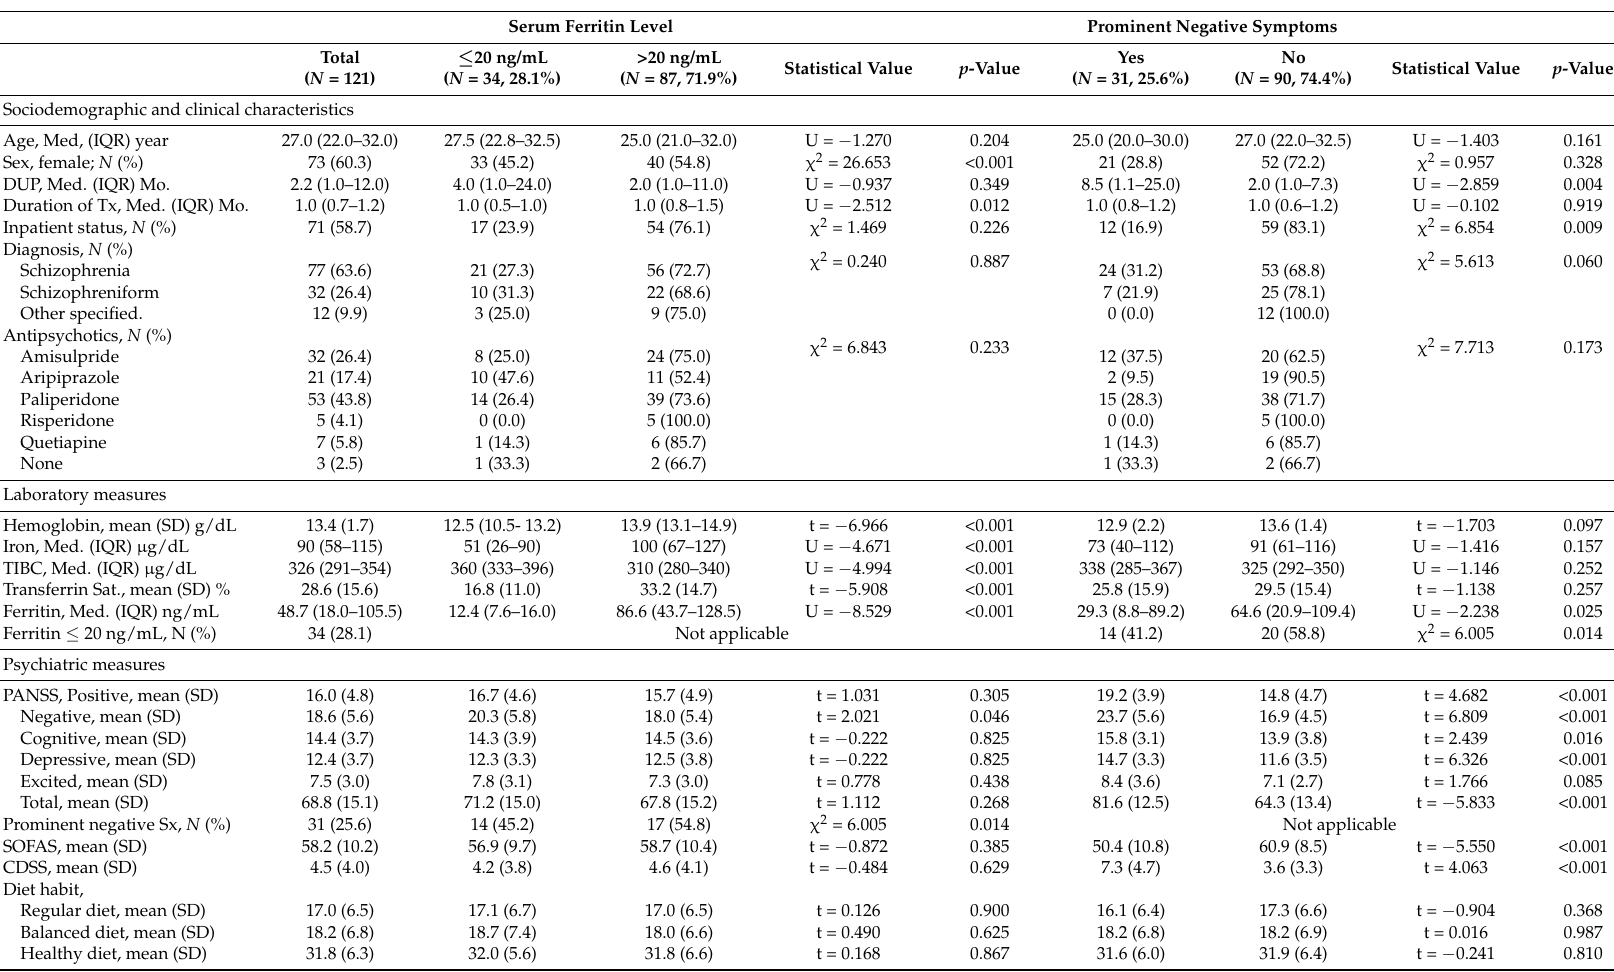
Table 1. Comparisons of sociodemographic and clinical characteristics according to the presence of iron deficiency and prominent negative